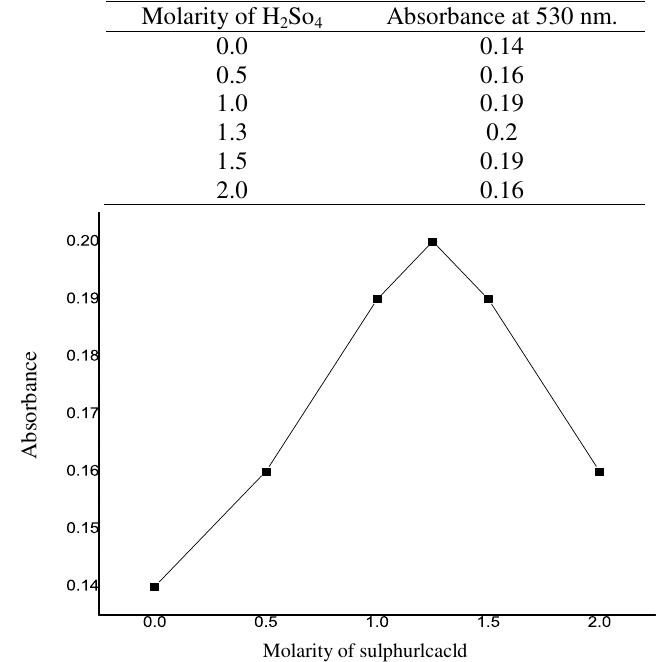
Table 3. Effect of varying the concentration of sulfuric acid on [Dh 2+ ] [CoCl